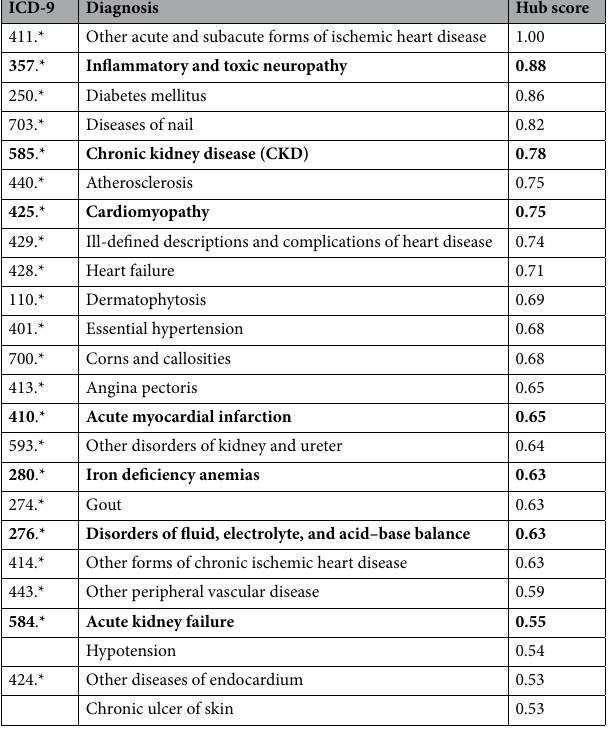
Table 3. Highest hub score diagnosis codes (n = 142). Bold denotes diagnoses that are among both top hubs and